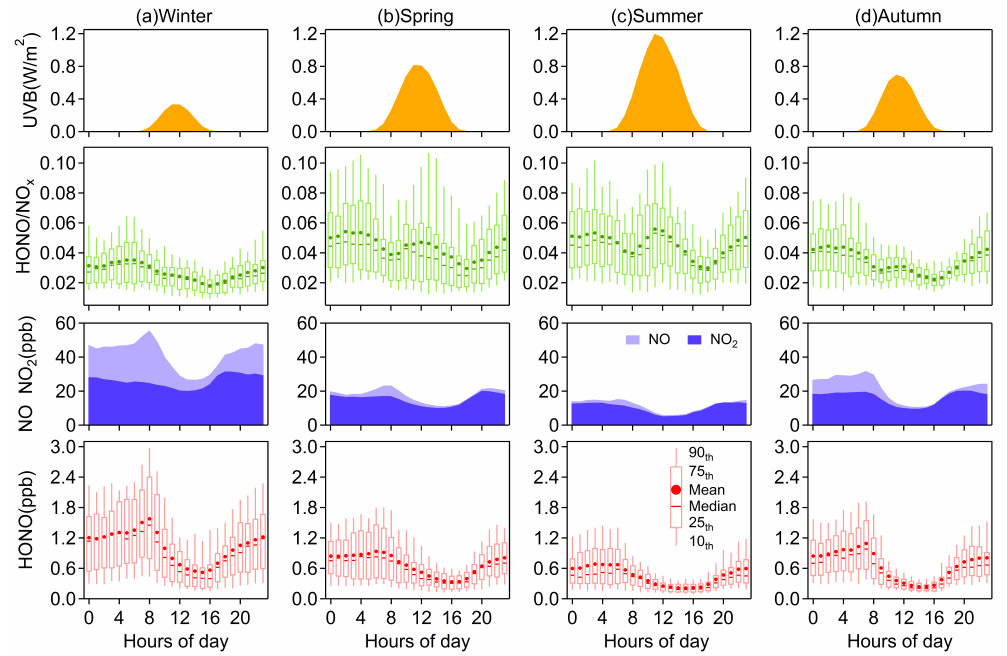
Figure 2. Diurnal variations of HONO, NO, NO 2 , HONO / NO x , and UVB in (a) winter, (b) spring, (c) summer, and (d) autumn. The levels of NO, NO 2 and UVB are displayed as their mean